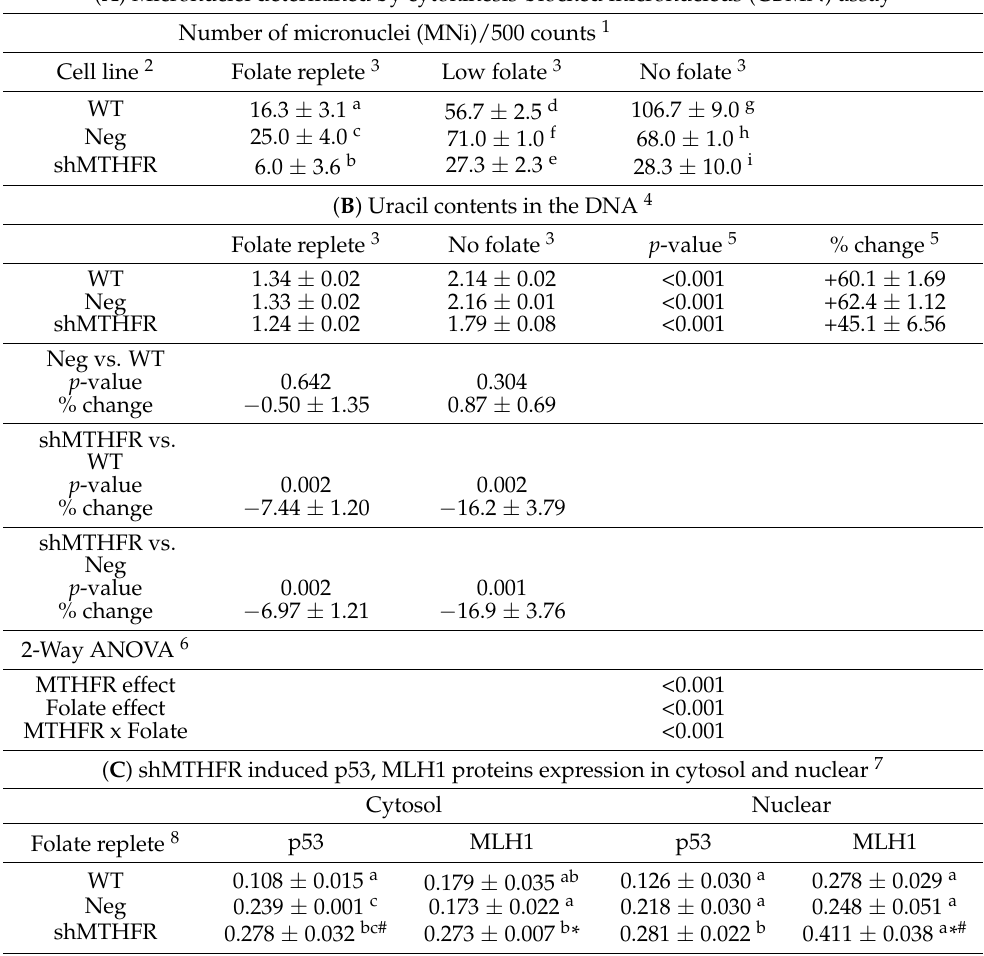
Table 6. shMTHFR reduced folate deficiency induced micronuclei formation and DNA uracil misincorporation in HepG2